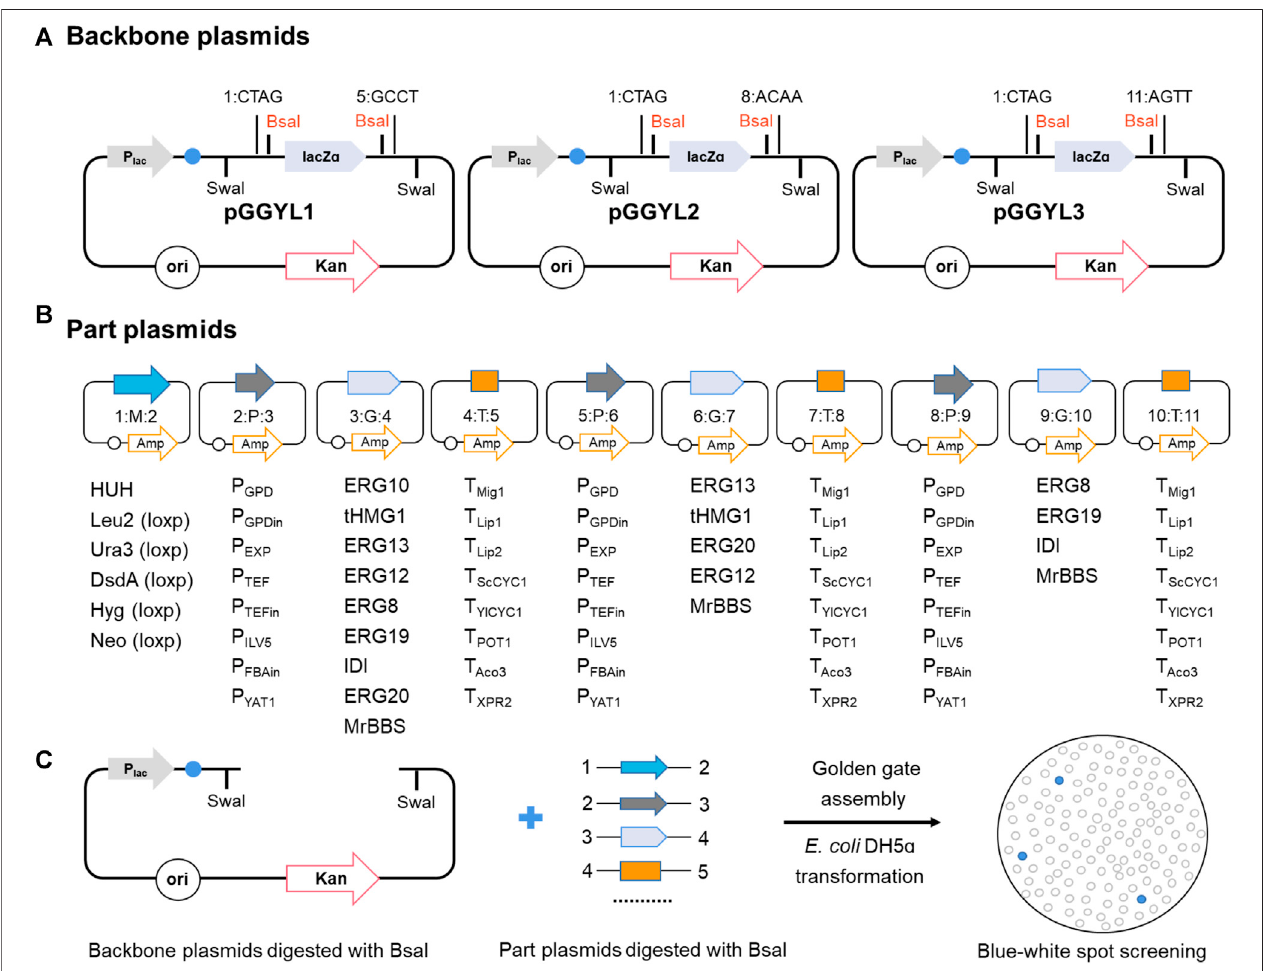
FIGURE 1 | Non-homologous end-joining (NHEJ) integration-based Golden Gate cloning toolkit dedicated to Yarrowia lipolytica . (A) The backbone plasmid pGGYL1-3 was designed for the assembly of 4, 7, and 10 DNA fragments covering 1 – 3 transcription units, respectively. Swa I recognition sites were included to cut the assembled selection marker and transcription unit for Y. lipolytica transformation. (B) Building blocks, including the selection marker, promoters, coding gene, and terminator, were cloned into pUC57-T7-FCC1 to generate building block plasmids. The building blocks were fl anked with predesigned 4-bp overhangs. The Bsa I cleavage sequences at the junction sites of two building blocks were designed to be complementary with each other (each assigned a number from 1 to 11). (C) Schematic diagram of the NHEJ integration-based Golden Gate cloning toolkit. The backbone and building block plasmids were digested with Bsa I, assembled in one step, and used to transform Escherichia coli DH5 ɑ . White colonies were picked for veri fi cation.